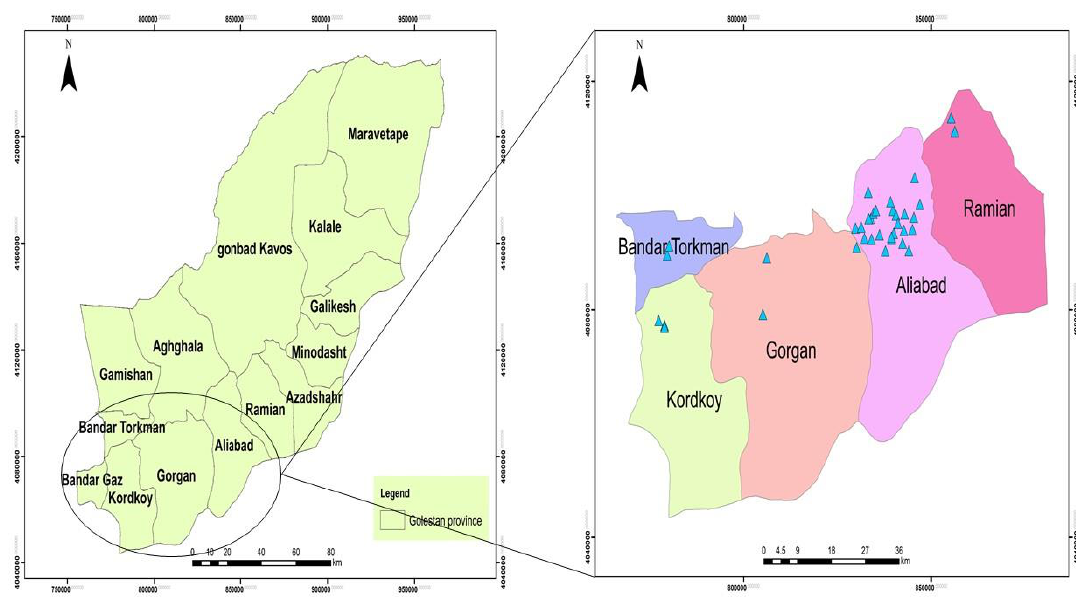
Figure 1. Geographical position of counties in Golestan province and distribution map of surveyed wheat fields in these counties. Circles indicate the field positions of the collected samples.